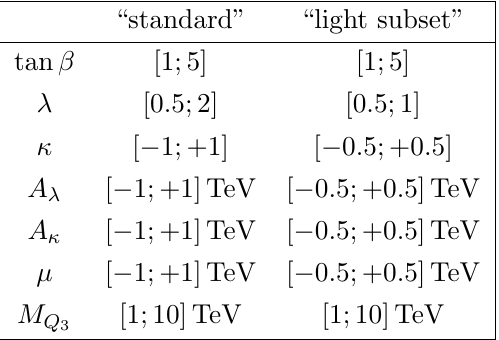
Table 1 . NMSSM parameter ranges used in NMSSMTools scans. We decouple the remaining supersymmetric partners by setting all sfermion mass parameters (except the stop parameters M Q = M U ) to 3 TeV, the bino and wino mass parameters to M 1 = M 2 = 1 TeV, and the gluino 3 3 mass to 2 TeV. The stop and sbottom mixing parameters are set to X t (cid:17) ( A t (cid:0) (cid:22) cot (cid:12) ) = 0 and X b (cid:17) ( A b (cid:0) (cid:22) tan (cid:12) ) = 0. See the text for a discussion of these choices as well as the ranges of the parameters we scan